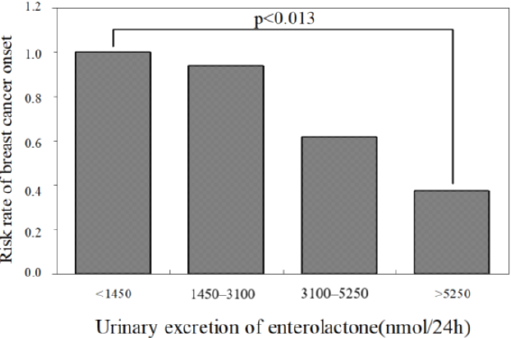
Figure 11. Breast cancer risk and urinary excretion of enterolactone in 144 subjects (data from Prof. H. Adlercreutz).